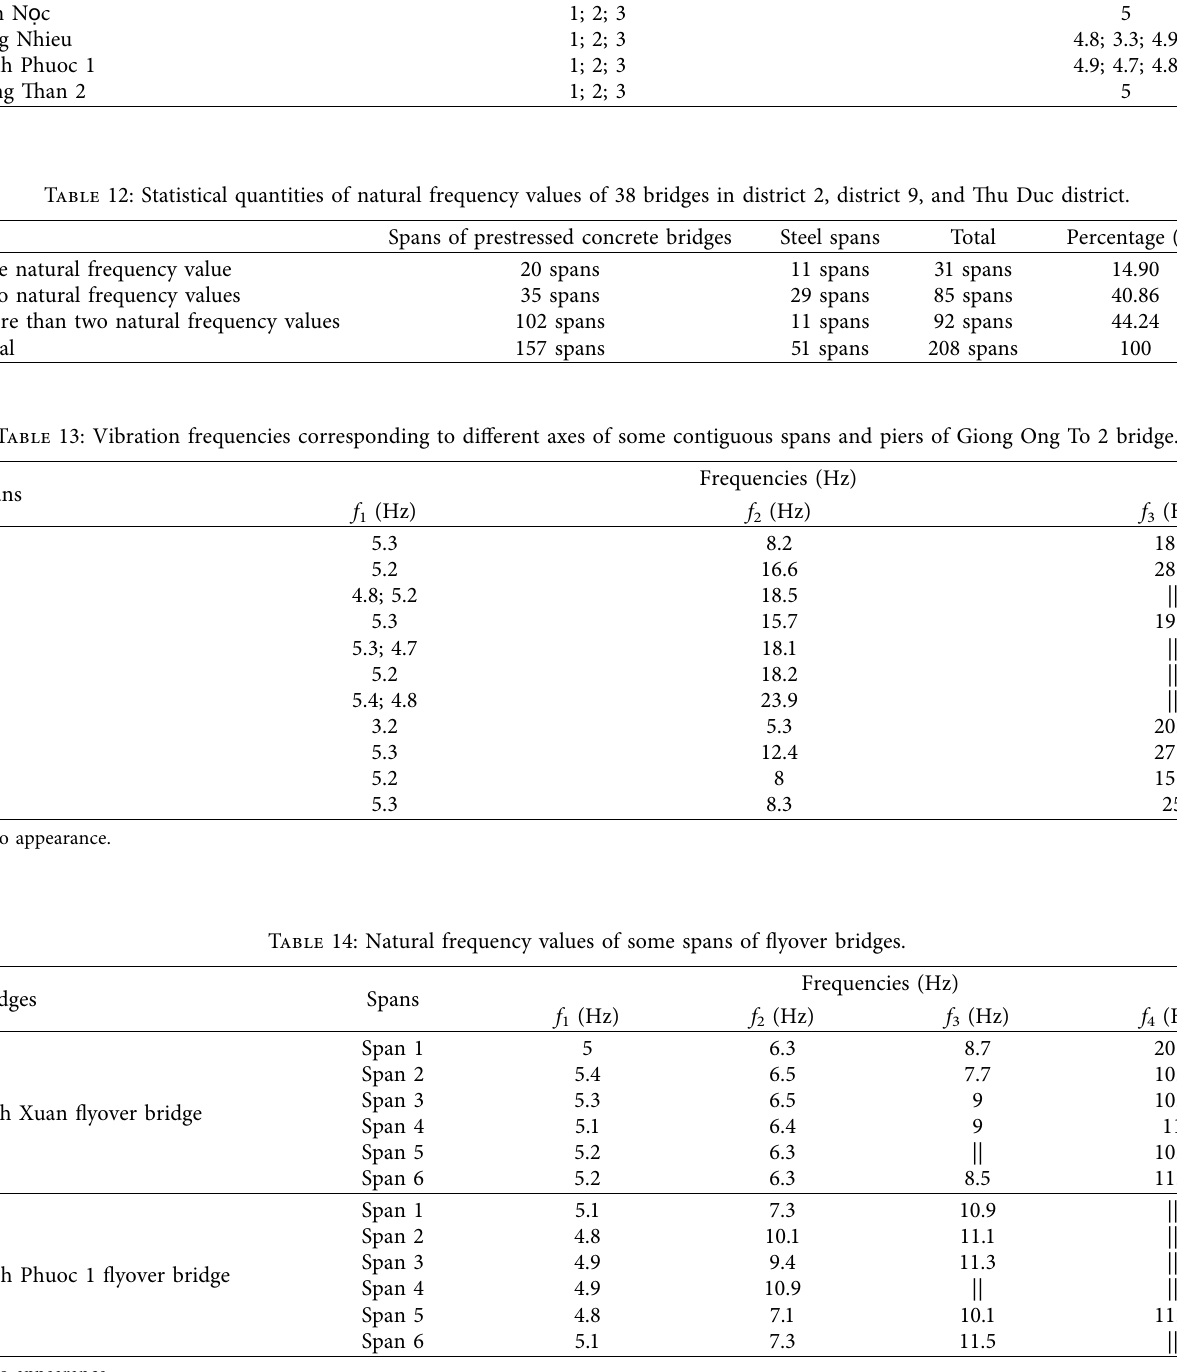
Linh Xuan flyover